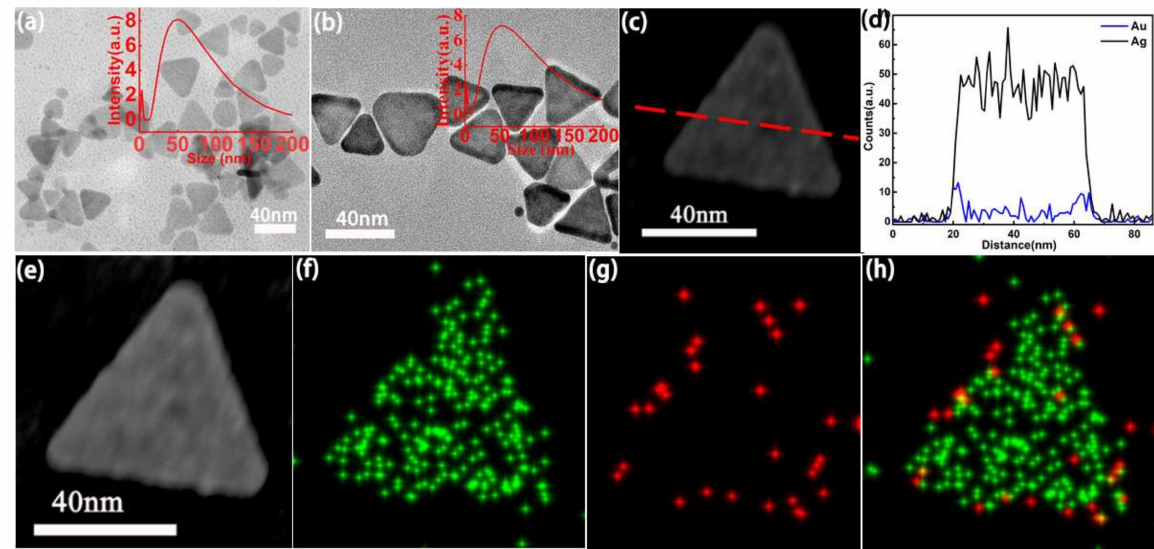
Figure 1. ( a ) TEM of Ag TNPs. Inset in the top-right corner shows the Ag TNPs size histograms. ( b ) TEM of Ag@Au TNPs. Inset in top-right corner shows the Ag@Au TNPs size histograms. ( c ) Scanning transmission image (STEM) of Ag@Au TNPs: a single Ag TNP coated with a thin layer of Au, ( d ) EDS elemental line scan taken along the red dotted line in d to demonstrate the elemental composition of the core and shell of the TNPs. ( e ) STEM image of Ag@Au TNPs and the distribution of Ag ( f ) and Au( g ) on the Ag@Au TNPs respectively, and the distribution of Ag and Au elements ( h ) in the triangular